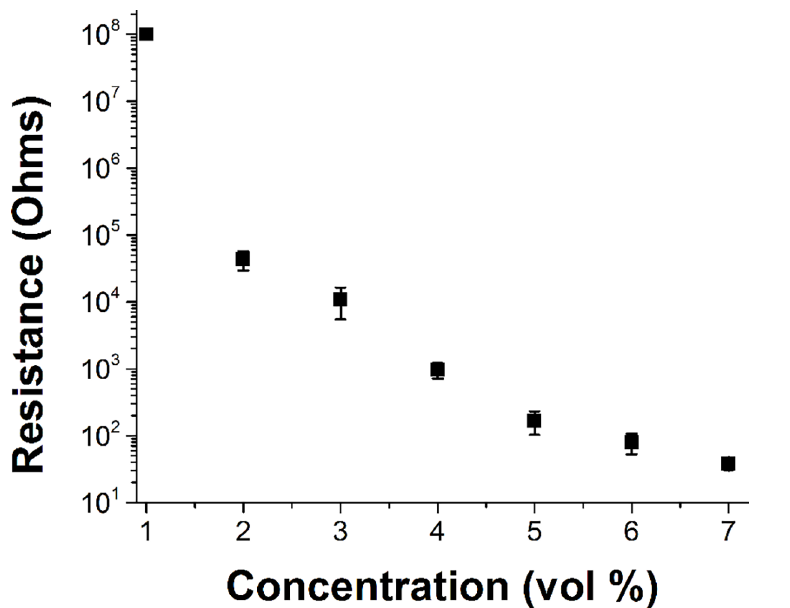
Fig 1. Resistance as a function of CNF concentration in the CNF-PDMS composites.